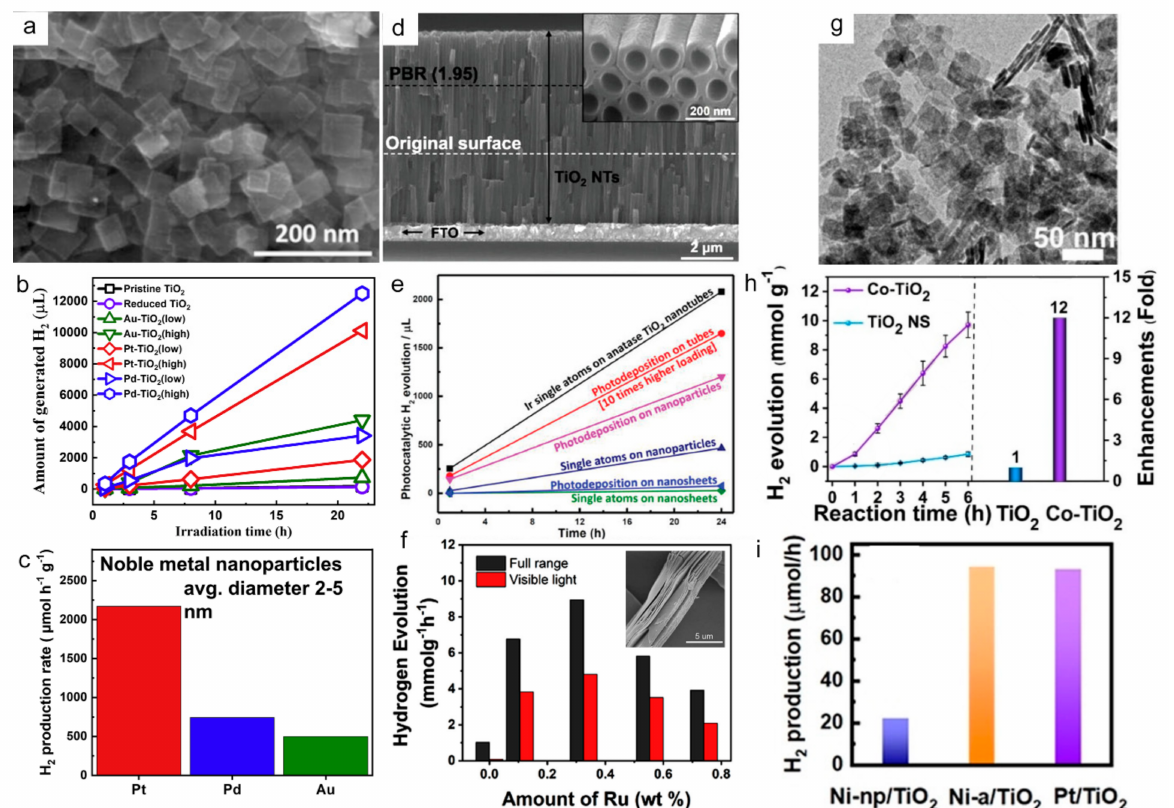
Figure 12. ( a ) SEM image of TiO 2 nanosheets. ( b , c ) Overview of the longtime H 2 evolution from TiO 2 nanosheets with different (low or high) noble metal SA loading (Au-TiO 2 , Pt-TiO 2 , and Pd- TiO 2 ) ( b ), H 2 evolution rate of TiO 2 nanosheets decorated with noble metal NPs with a diameter of ≈ 2–5 nm and loading of 1 wt.% (Pt, Pd, or Au, respectively) decorated NPs ( c ). Adopted with permission from Ref. [14] ( d , e ) SEM image of TiO 2 nanotubes ( d ), and photocatalytic H 2 evolution of Ir decorated TiO 2 samples. Adopted with permission from Ref. [134] ( e ) Time-dependent H 2 evolution and enhancement of evolution over Co-TiO 2 and TiO 2 NSs. Adopted with permission from Ref. [156] ( f ) H 2 production rate of Ru 1 /TiNS with different amounts of Ru. Adopted with permission from Ref. [140]. ( g , h ) TEM images of Co-TiO 2 ( g ), and Time-dependent hydrogen evolution and enhancement of evolution over Co-TiO 2 and TiO 2 NSs. Adopted with permission from Ref. [156]. ( i ) Comparison of H 2 evolution activity on Ni-NP/TiO 2 , Ni-SA/TiO 2 , and Pt/TiO 2 with the same loading amount (~0.5 wt.%). Adopted with permission from Ref.